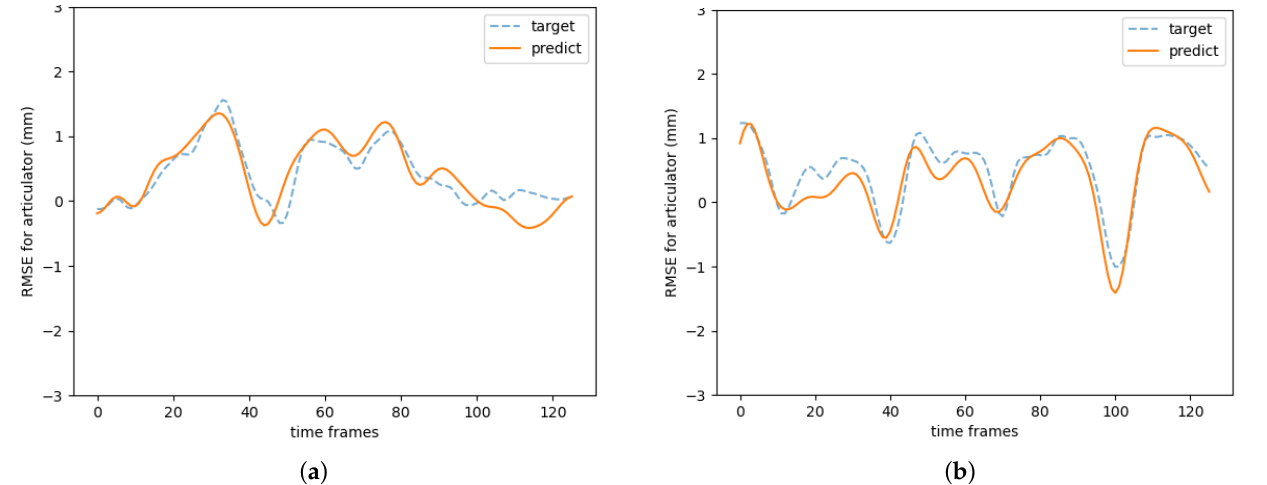
Figure 5. Trajectories of one specific articulator: tongue tip predicted by the proposed 256-channel TCN AAI system. The plot of the movements shows the target trajectory and the predicted one. ( a ) TT_X; ( b )